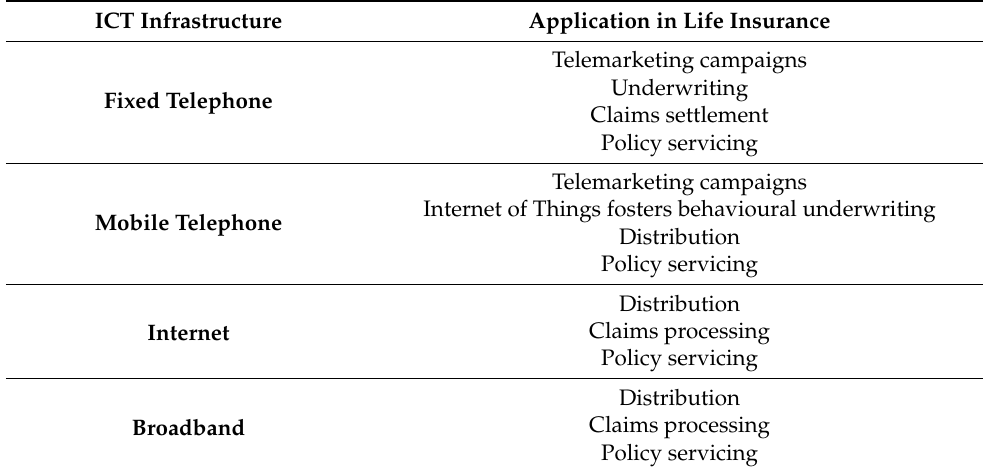
Table 1. ICT infrastructure application in life